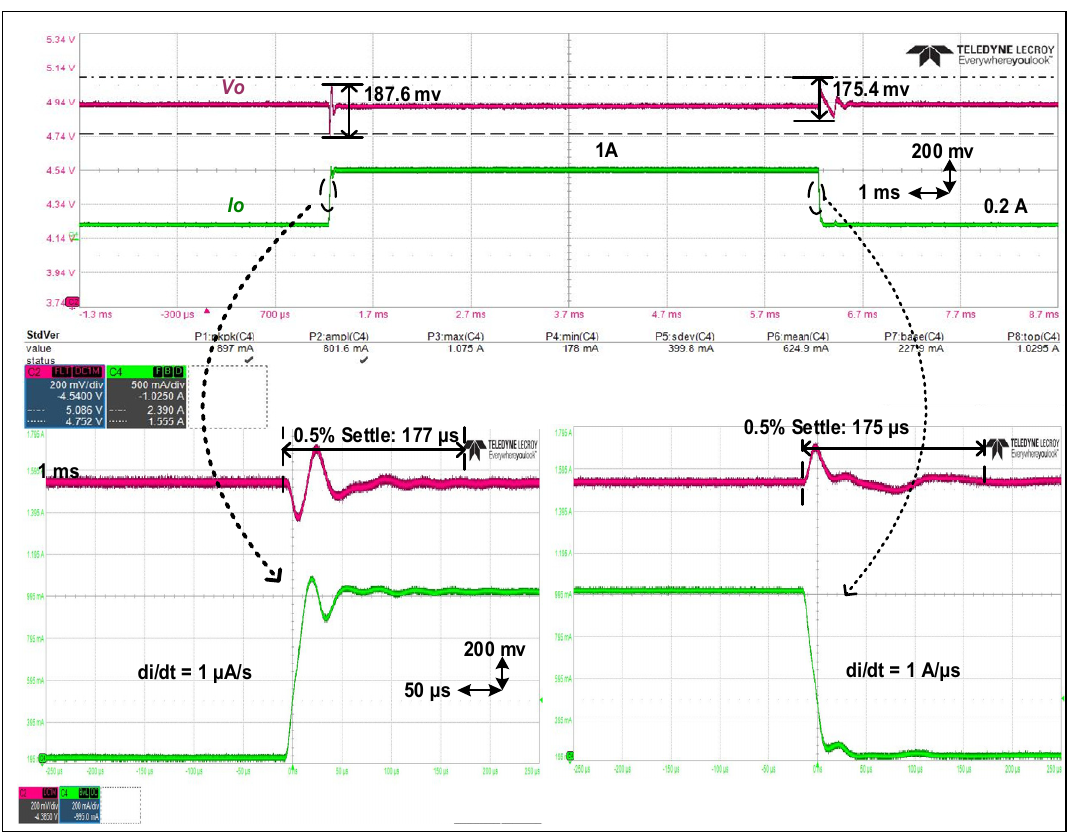
Figure 8. The chip micrograph.